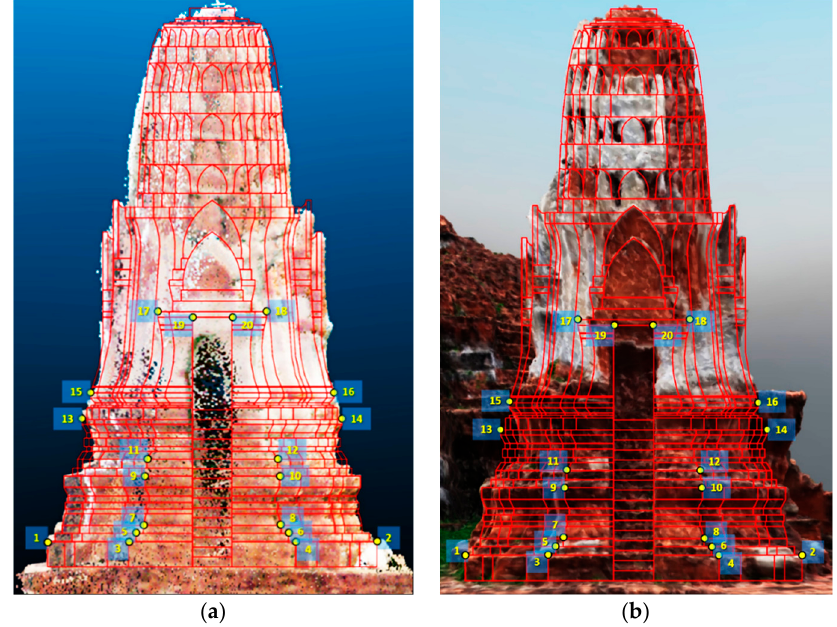
Figure 8. Comparison of the terrestrial and UAVs point cloud computed on 20 checkpoints for the Prang structure. ( a ) Point clouds from terrestrial laser scanning (TLS). ( b ) Point clouds from UAV.